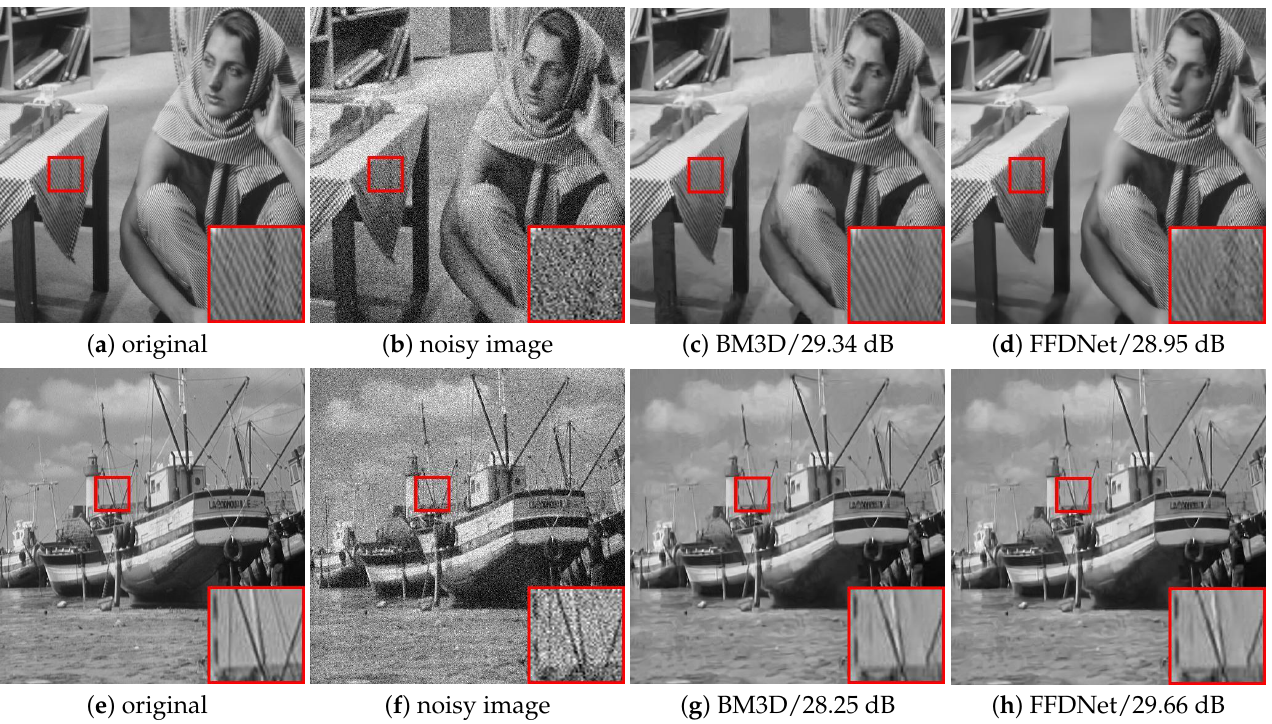
Figure 2. Denoising results of Barbara and Boat with noise level σ =